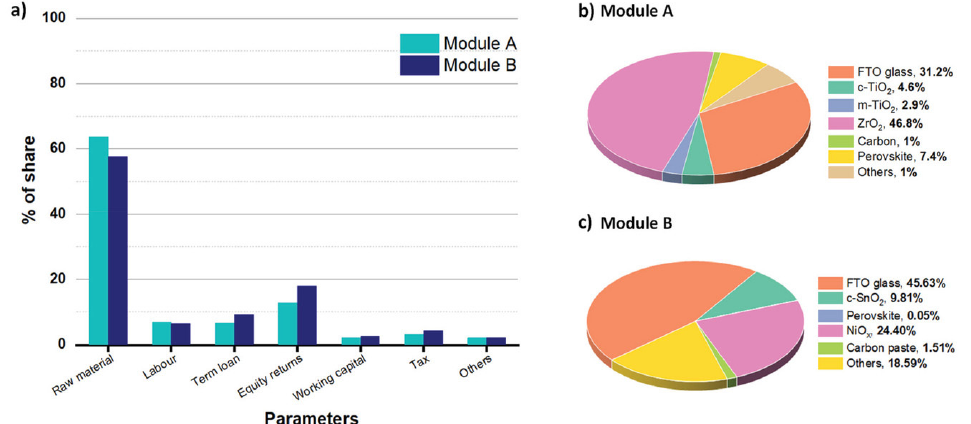
Figure 34 . ( a ) Different parameters and their share analysis for both modules, ( b ) material share for Module A, and ( c ) material share for Module B [123]. (Reprinted with permission from Ref. [123], 10.1002/gch2.202100070, under the terms of the CC BY [3.0] license Copyright © 2021Wiley - VCH